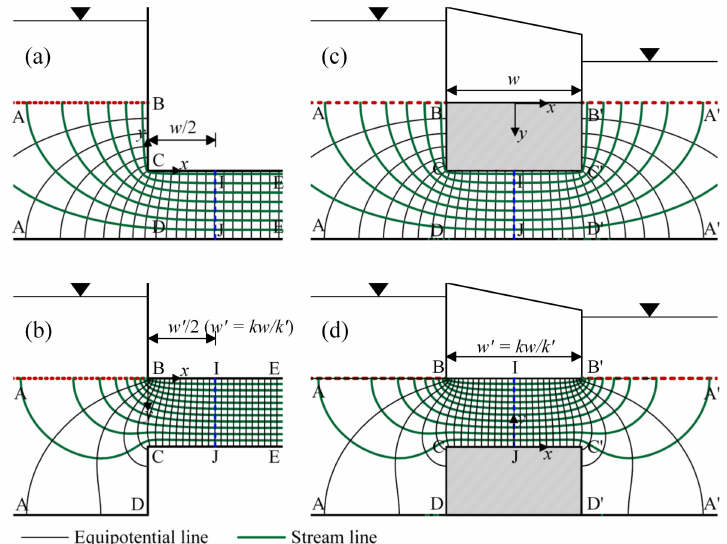
Figure 5. Consistency in the flow nets between the approximate and exact models when the ratios w / d and w’ / s are sufficiently large: ( a , b ) show the calculated flow nets for the approximate models, respectively; ( c , d ) show the calculated flow nets for the exact models,